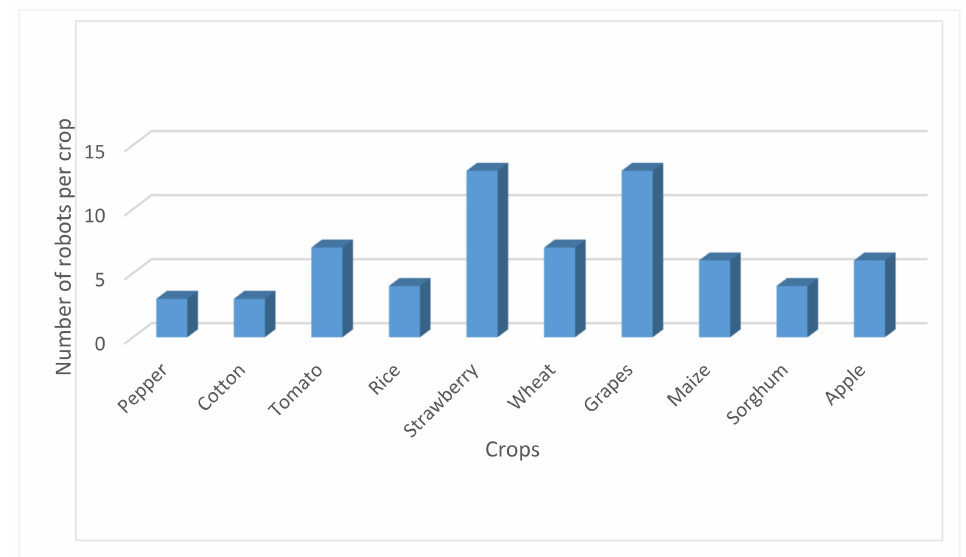
Figure 5. The main crops in correlation with the number of robotic systems.